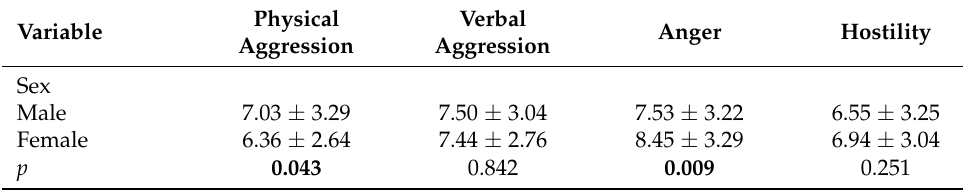
Table 2. Bivariate analysis of the categorical variables associated with aggression scores.